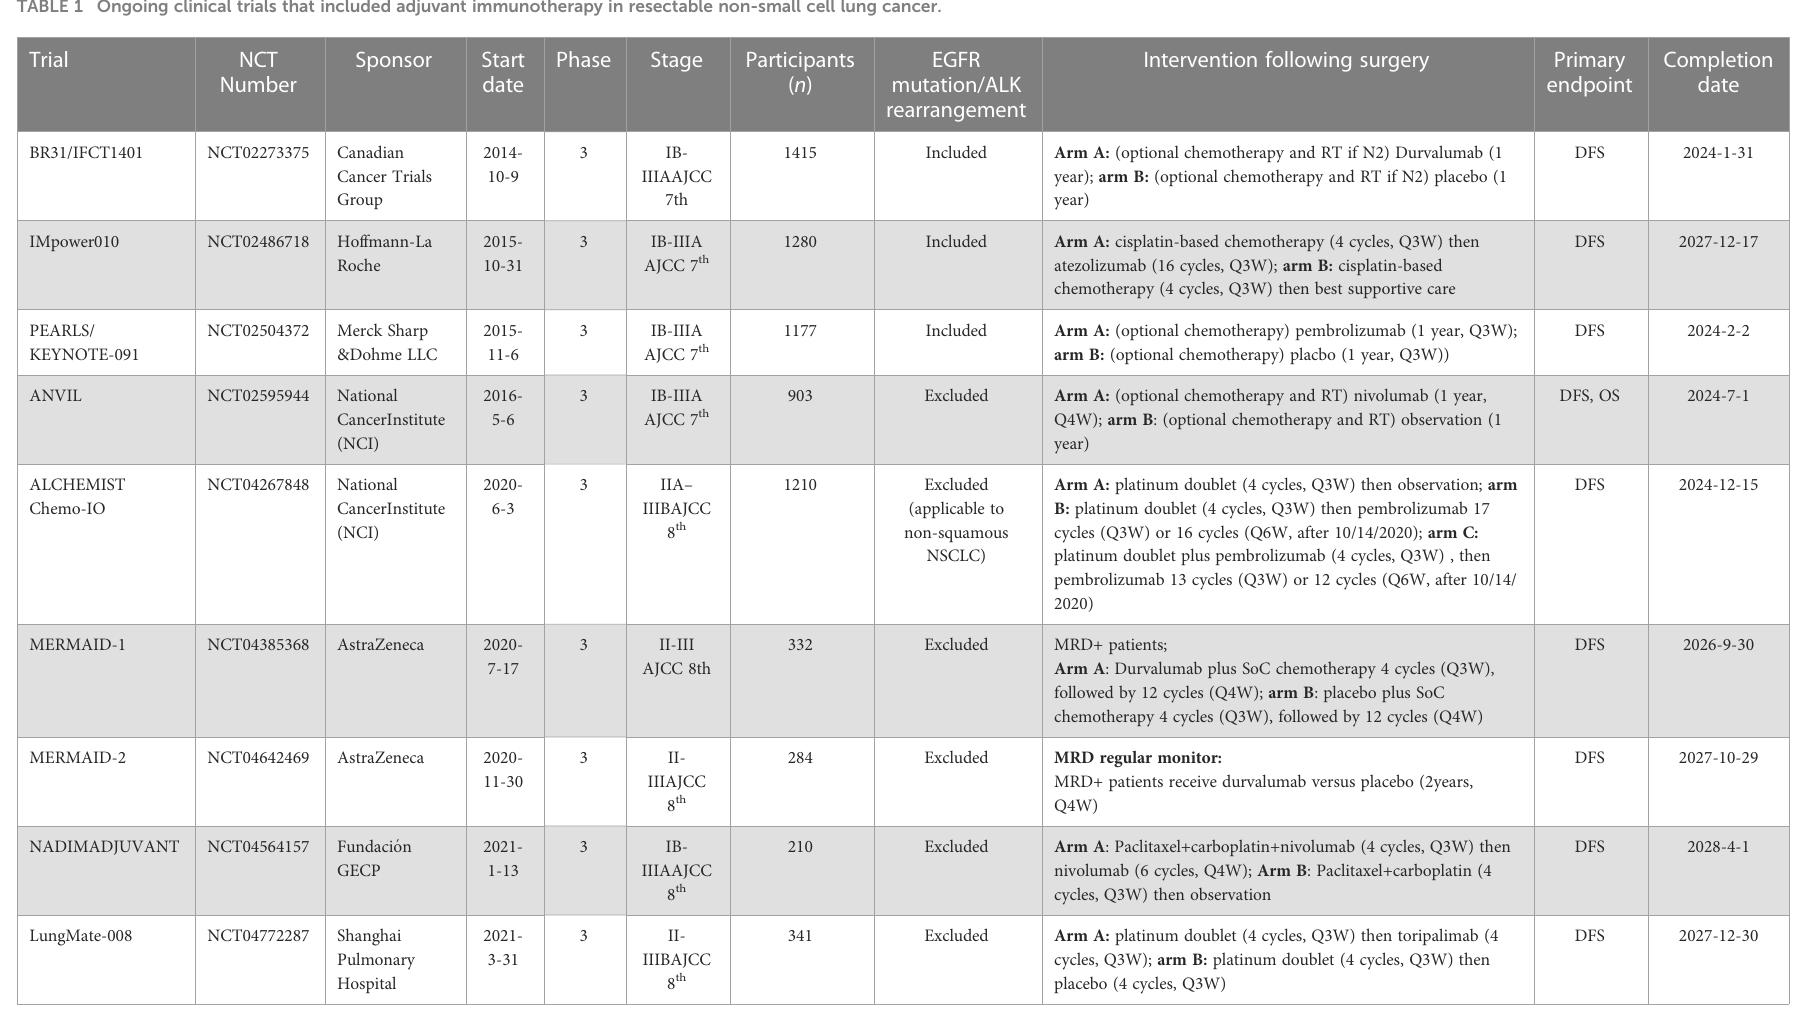
TABLE 1 Ongoing clinical trials that included adjuvant immunotherapy in resectable non-small cell lung